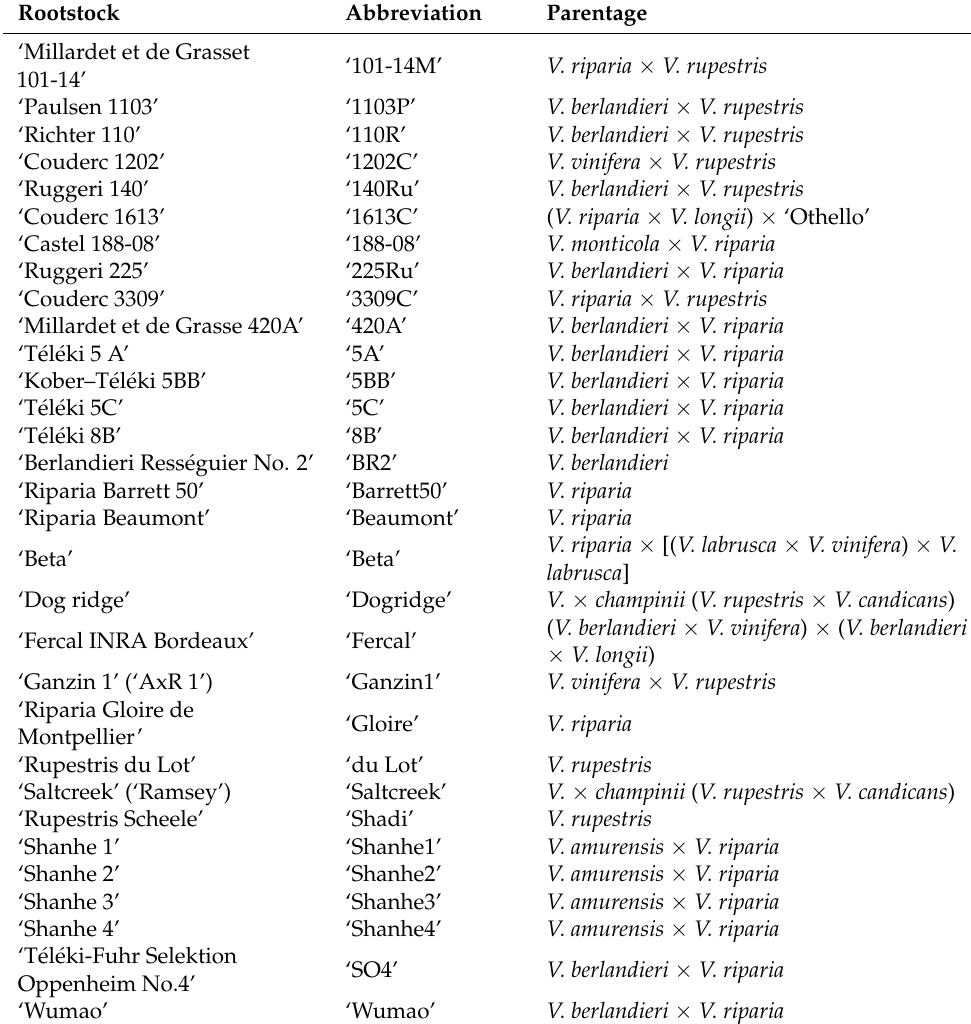
Table 1. Thirty-one grapevine rootstocks used in the trial and their abbreviations and parentage